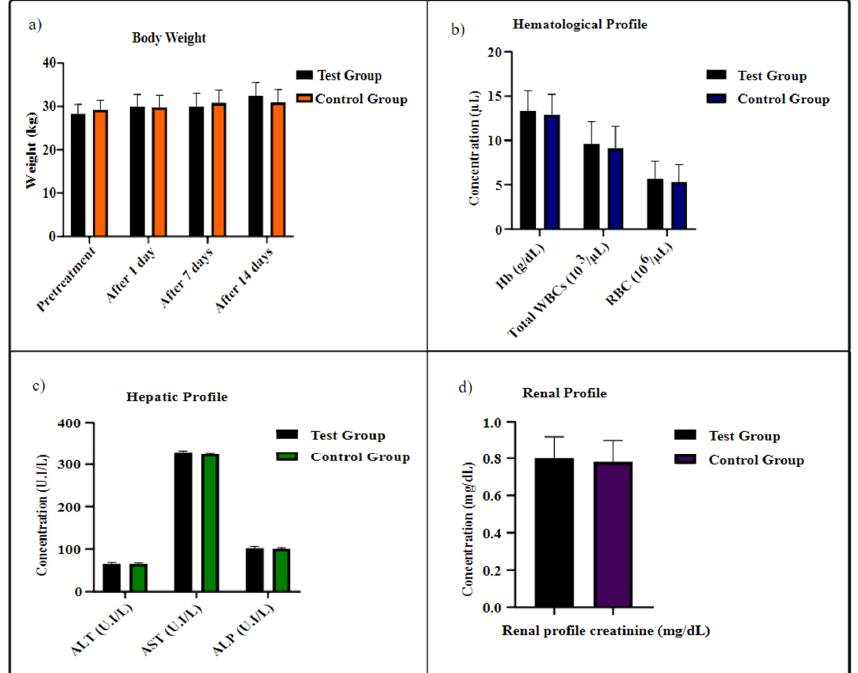
Figure 5. Biochemical profile of albino mice after repeated dose administration over a time duration of 14 days ( a ) body weight, ( b ) hematological profile, ( c ) hepatic profile, ( d ) renal profile Results are represented as mean ± S.D. with n = 7 and p < 0.05